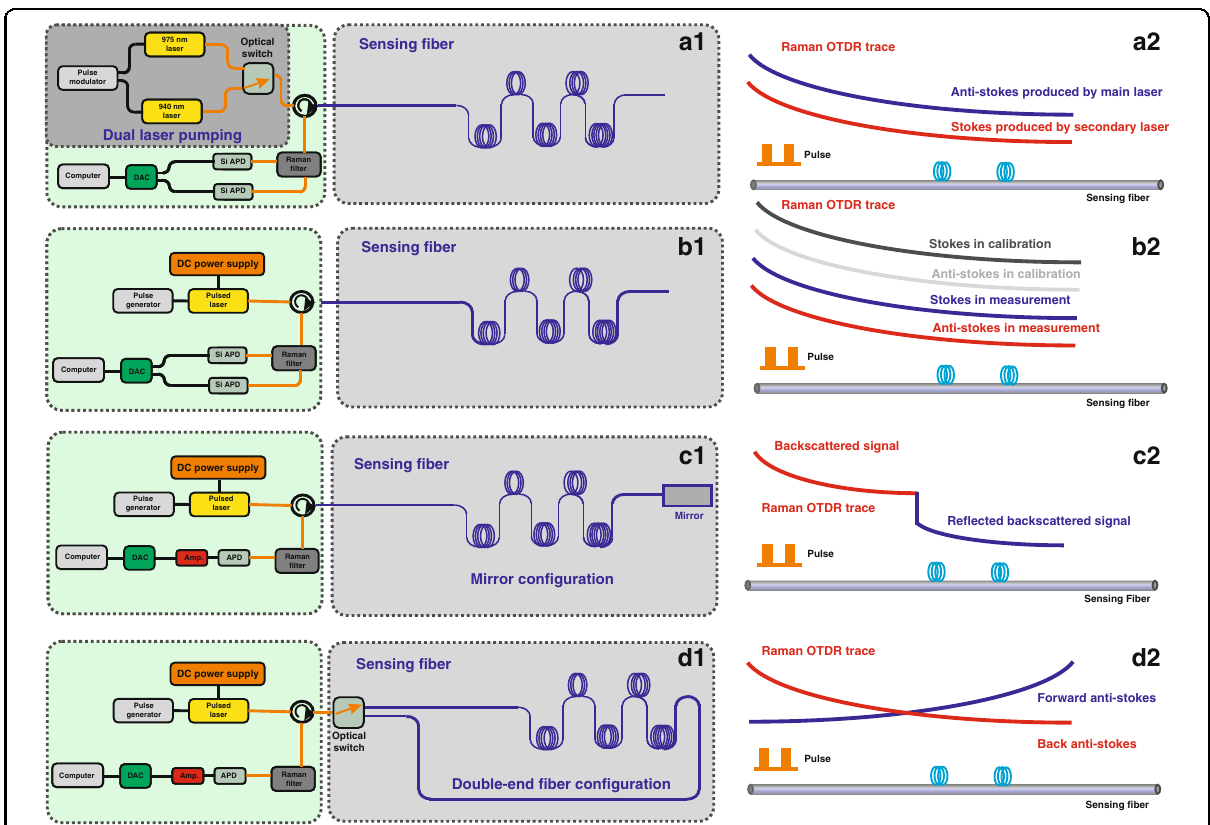
Fig. 3 Advanced compensation schemes for attenuation difference proposed by researchers. a1 Dual laser pumping scheme. a2 Raman OTDR traces based on dual laser pumping. b1 Optical attenuation calibration scheme and ( b2 ) Raman OTDR traces based on the optical attenuation calibration scheme of the entire sensing fi ber. c1 End re fl ection self-calibration scheme. c2 Raman OTDR traces based on the end re fl ection self- calibration. d1 Double-end loop demodulation scheme. d2 Raman OTDR traces based on double-end loop